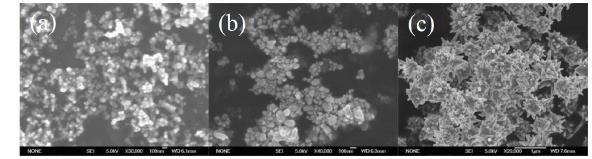
Figure 6: FESEM images of Ni, Cu, and Ni1Cu1